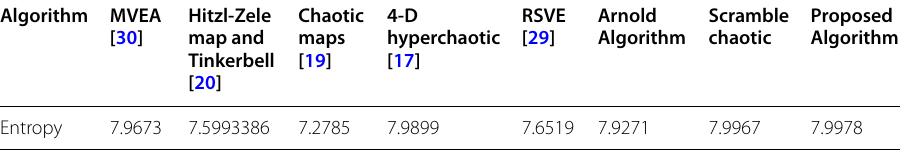
Table 2 The information entropy by the proposed method in different videos Algorithm MVEA